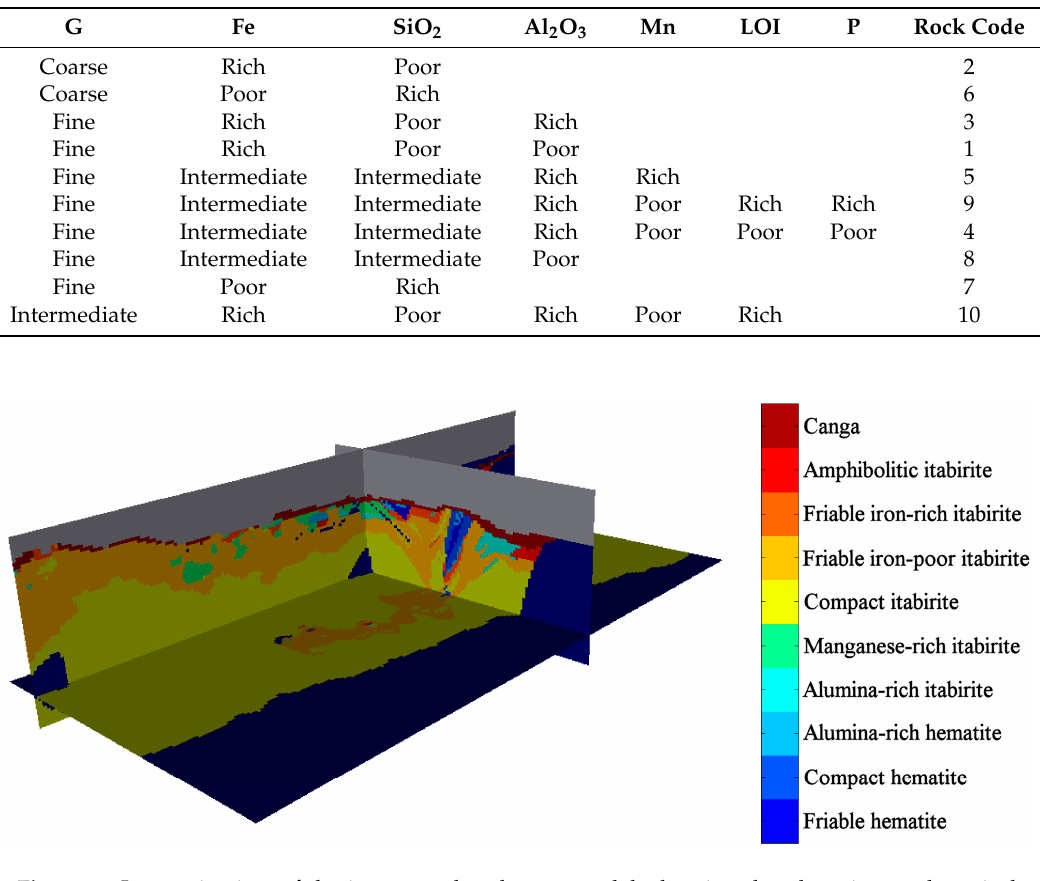
Figure 1. Isometric view of the interpreted rock type model, showing the plan view and vertical cross-sections passing through the origin (local coordinate system). Waste and air are shown in dark blue and grey, respectively.